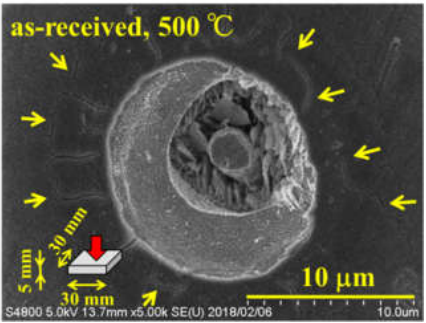
Figure 9. SEM images for the Cr–Mo steel (SCM435) surface after stress relaxation behavior by heat.